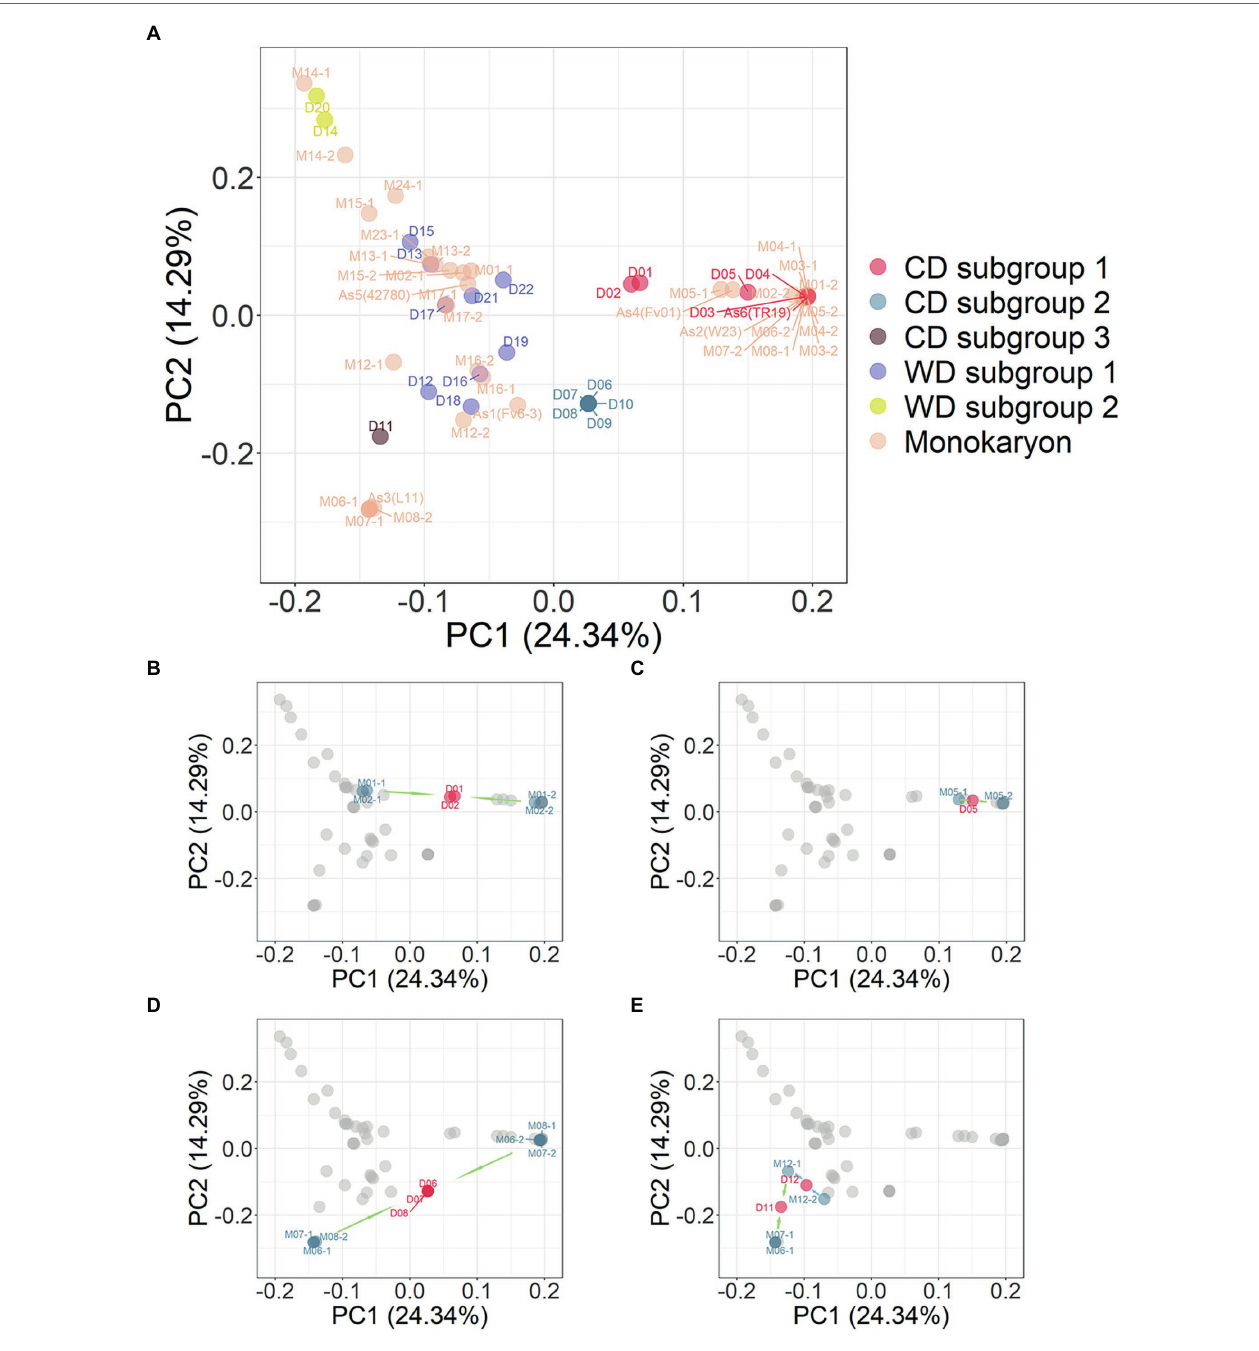
FIGURE 5 | (A) PCA plot of combination 23 dikaryotic and 35 monokaryotic strains of Flammulina filiformis . The dikaryon strains were denoted by D number, and the monokaryon strains were denoted by M number, and the numbers of dikaryon and the constituent monokaryons strains were consistent. (B) Dikaryon strains D01 and D02 and their constituent monokaryon in PCA. The arrow marks represent dikaryon with constituent monokaryons. (C) Dikaryon strains D05 with constituent monokaryon in PCA. (D) Dikaryon strains D06, D07, and D08 with their constituent monokaryon in PCA. (E) Dikaryon strains D11 and D12 with their constituent monokaryon in